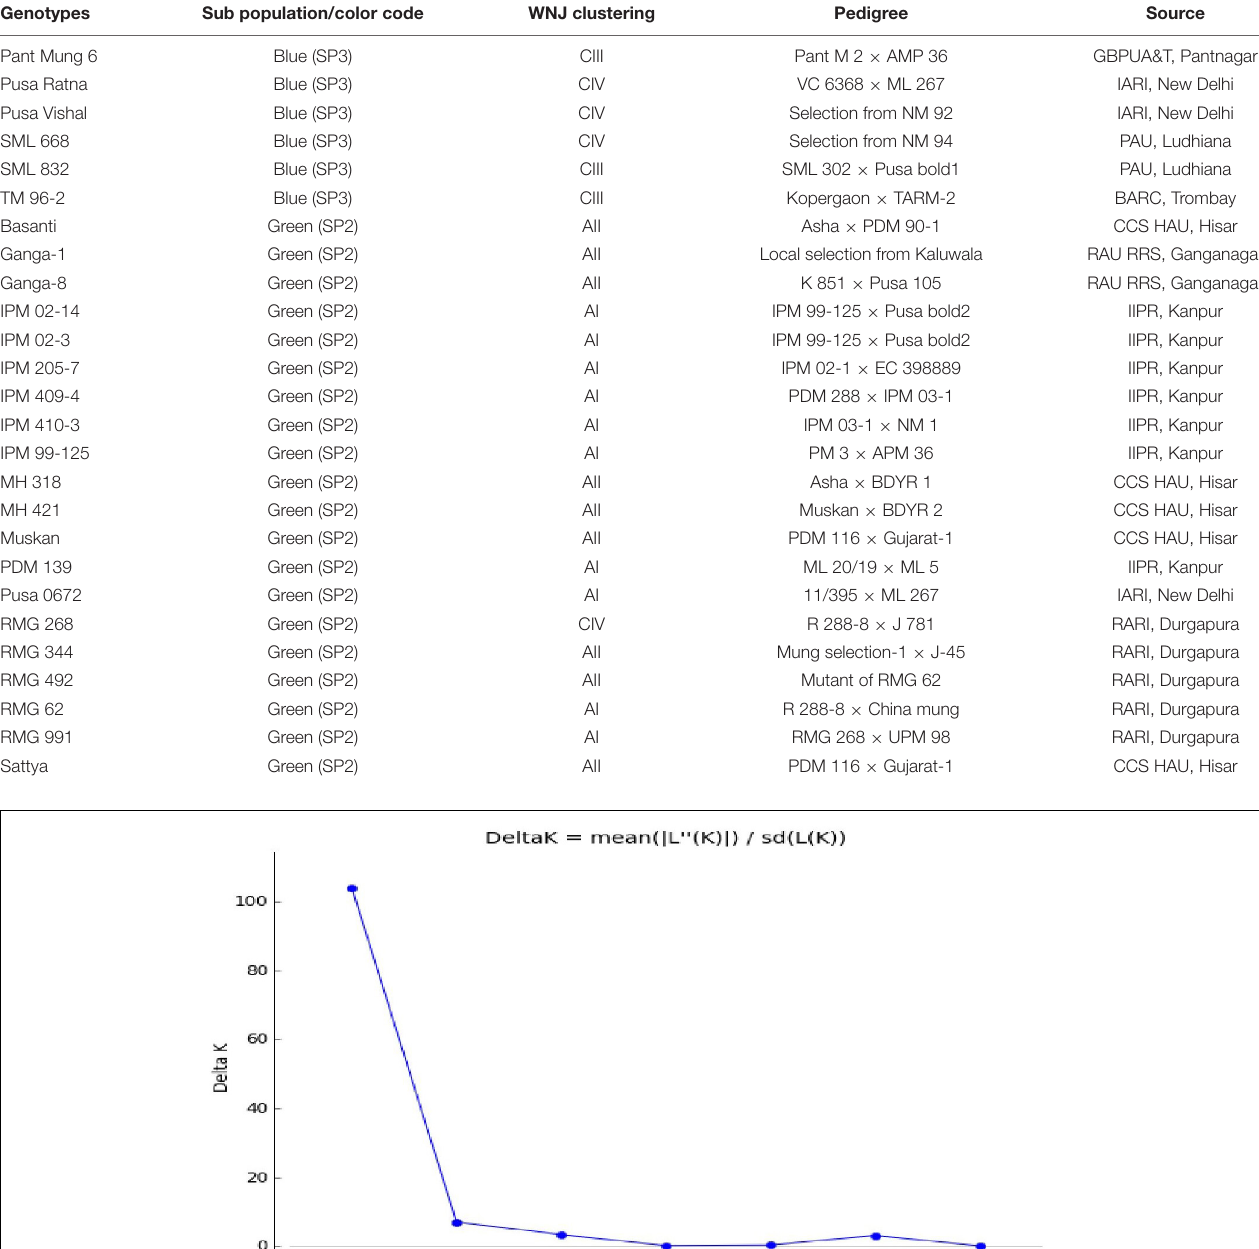
to 0.49 (between VR039 and SSR188). The R 2 value above 0.1 between marker pairs was considered to be in LD, and there were 75 marker pairs having the R 2 value above 0.1. The marker BMd23 had the highest LD with 16 markers (i.e., BMd35, BM212, BMD6, CEDC55, CEDG185, CEDG70, CP1038,